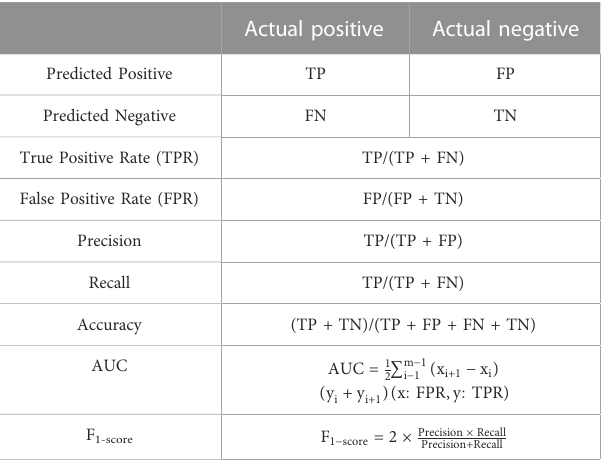
TABLE 3 The metrics used in the evaluation of model.